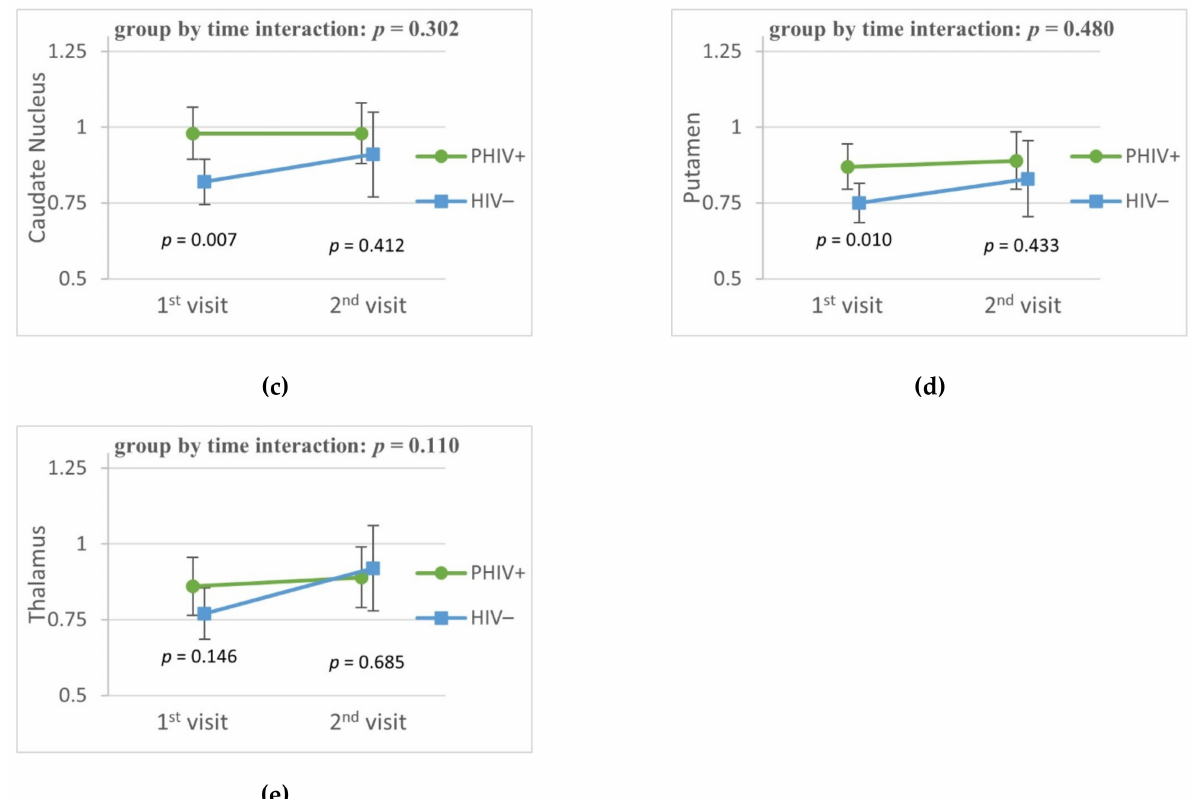
Figure 2. CBF changes in cohort. The graphs show longitudinal changes in CBF of PHIV+ adolescents compared to controls matched for age, sex, ethnic background. Figures show plotted least square means and their 95% confidence interval of CBF in the specific region as a ratio to mean GM CBF of controls. ( a ) = gray matter; ( b ) = white matter; ( c ) = caudate nucleus; ( d ) = putamen and ( e ) = thalamus. P values are the group by time interaction adjusted for age and sex. Additional p values are the cross-sectional difference at first and second visit. Abbreviation: CBF = cerebral blood flow; GM = gray matter, WM = white matter.